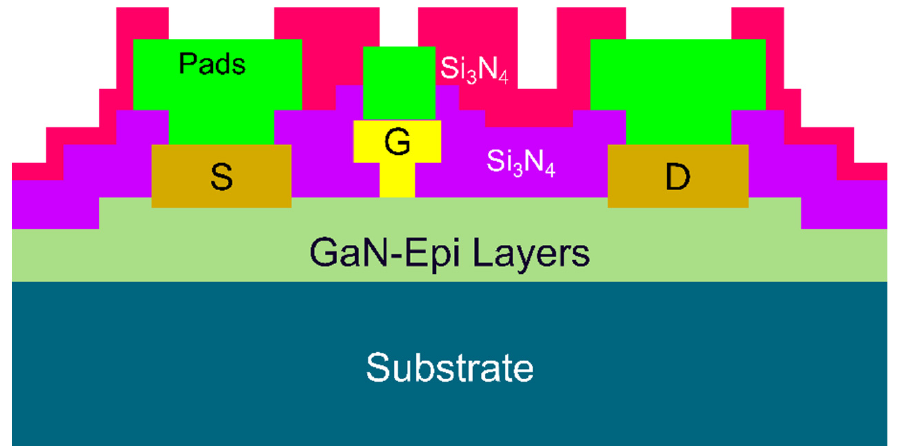
Figure 2. GaN HEMTs cross-section view for the fabricated devices.